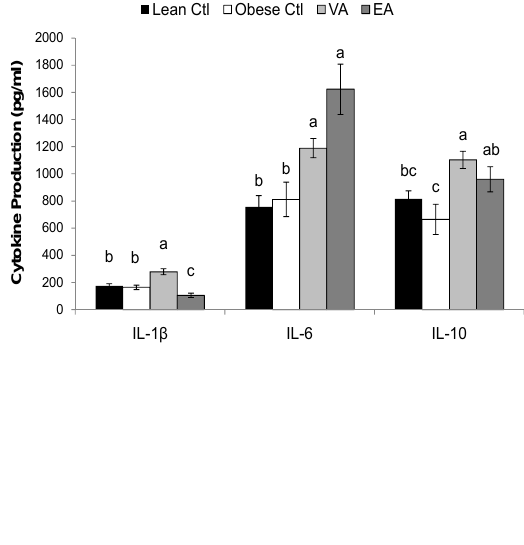
Figure 2. LPS-stimulated cytokine production. Bars represent mean ± SEM, n = 8/group. Bars not sharing a common letter are significantly different (P < 0.05). Ctl, control; VA, vaccenic acid; EA, elaidic acid. TNF- α production did not differ among groups (458 ± 42, n =